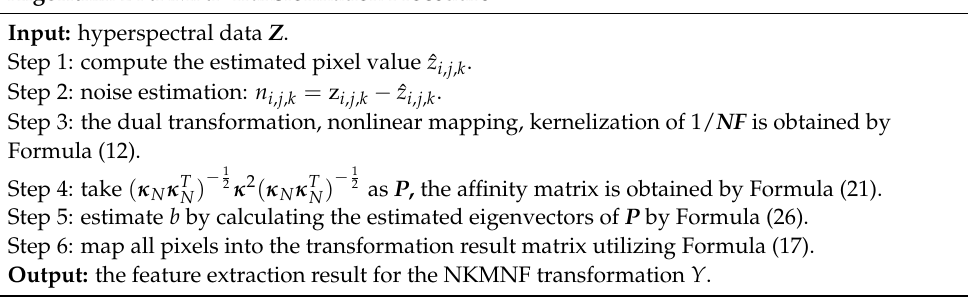
Algorithm 2 NKMNF Transformation